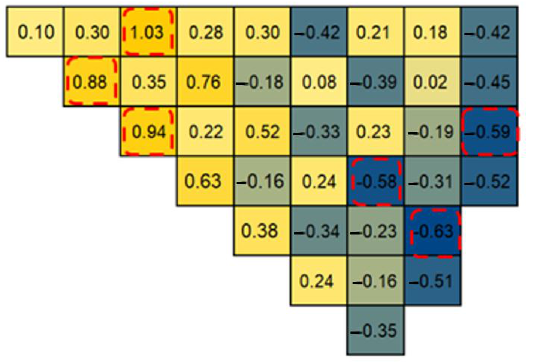
Figure 19. In-out tilt in assembly-wise radial power distribution with default TCP 0 scattering in HZ1